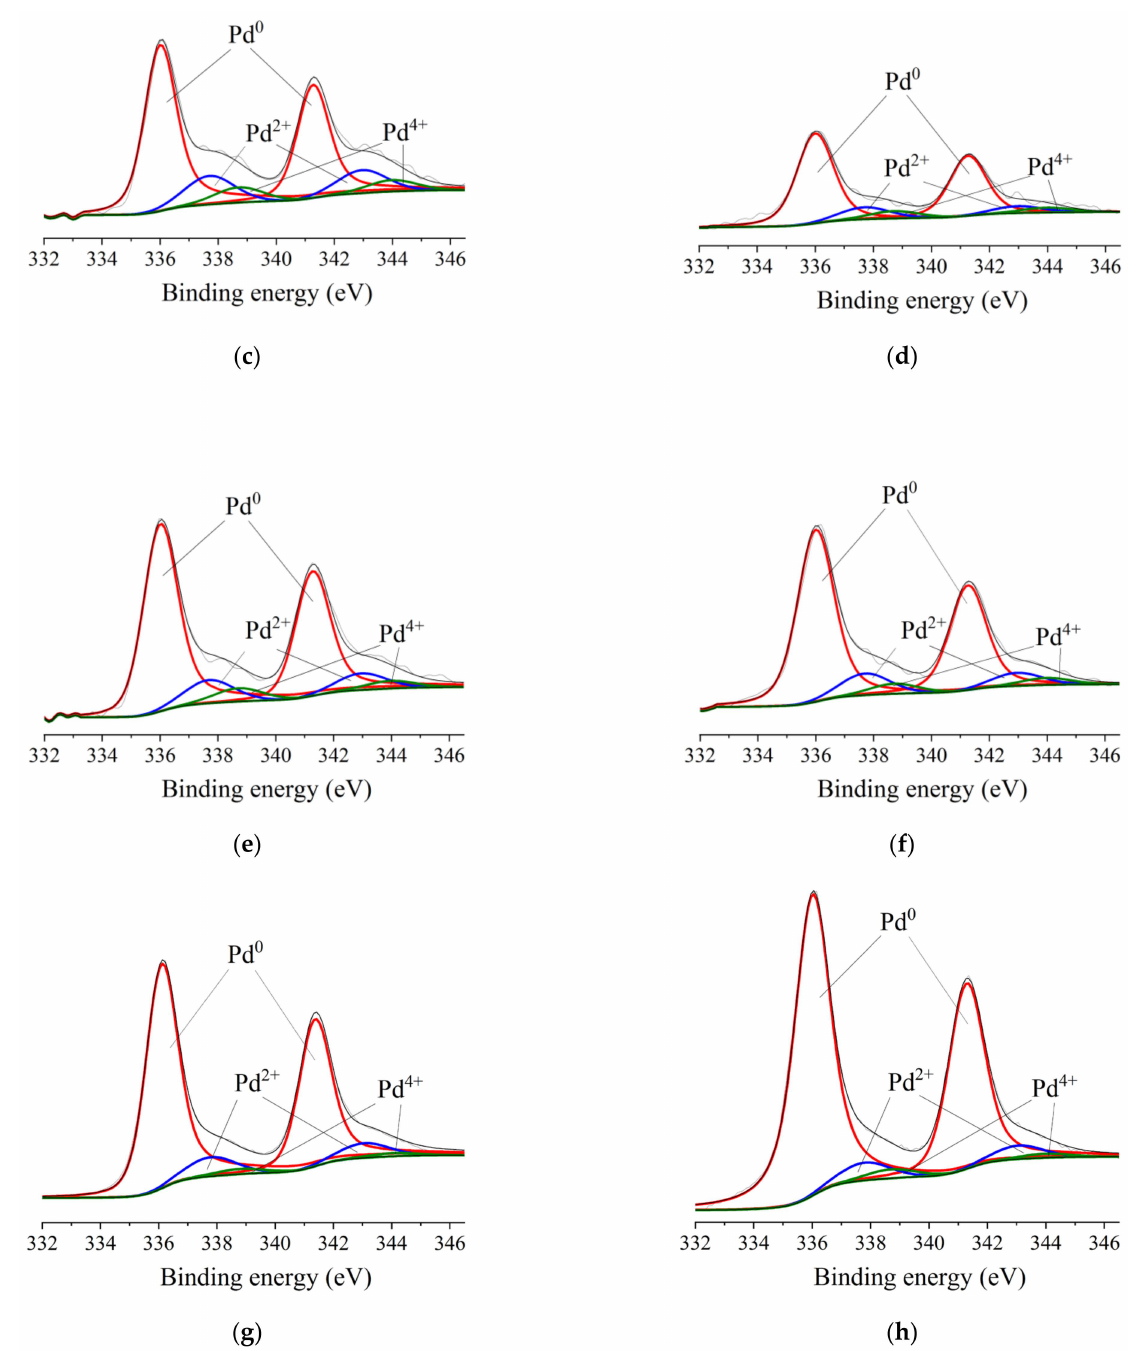
Figure 6. Pd3d XPS spectra: ( a ) Pd/Cp; ( b ) Pd-Au/Cp; ( c ) Pd/Cp-COOH; ( d ) Pd-Au/Cp-COOH; ( e ) Pd/Cp-butyl; ( f ) Pd-Au/Cp-butyl; ( g ) Pd/Cp-NH 2 ; ( h ) Pd-Au/Cp-NH 2